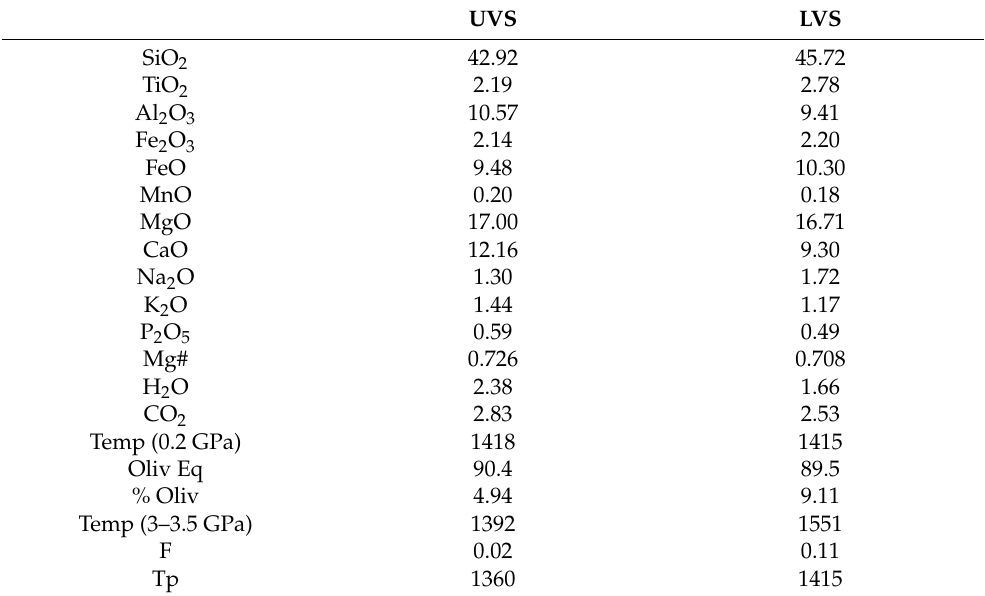
Table 4. Model Christmas Island parental liquids and estimates of potential petrogenetic conditions at 3–3.5